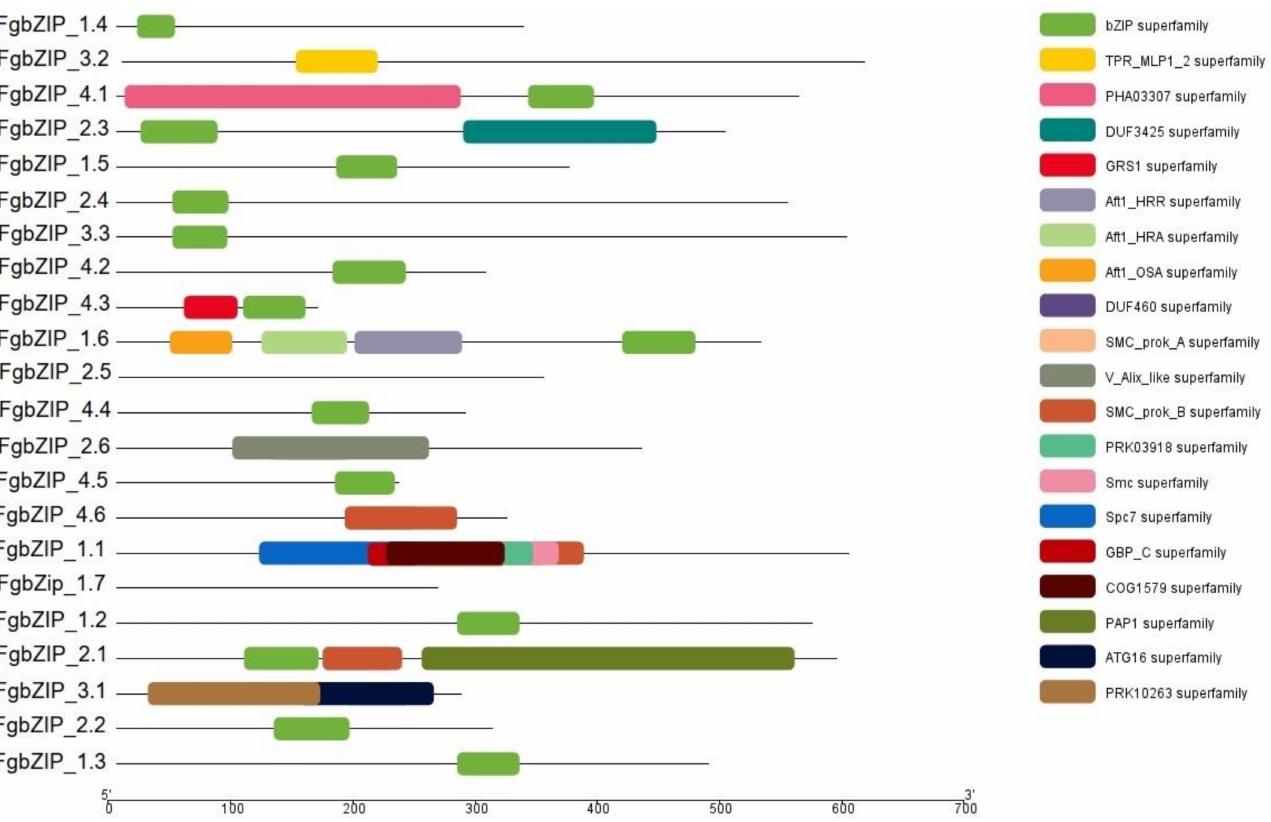
Figure 5. Conserved motif analysis of bZIP genes derived using Pfam figure showing conserved motifs highlighted in different colors, where bZIP is prominent in each